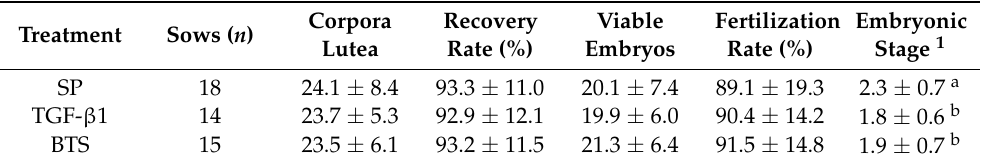
Table 1. Reproductive parameters in pregnant “donors” obtained 6 days after the infusions of seminal plasma (SP), Beltsville Thawing Solution (BTS) extender containing 3 ng/mL of porcine TGF- β 1 (TGF- β 1), or BTS alone (control) 30 min prior to insemination.